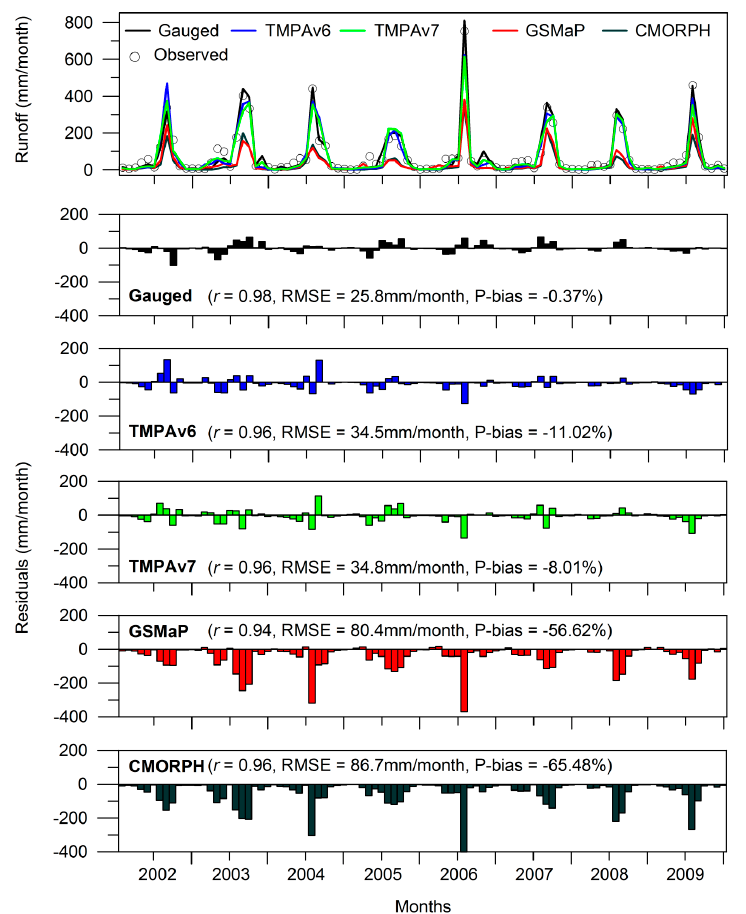
Figure 6. Comparison of monthly dam inflow observations and simulations from use of the satellite-derived precipitation products ( top panel ) and the respective residuals ( lower panels ) calculated as the monthly observation minus the simulated value.